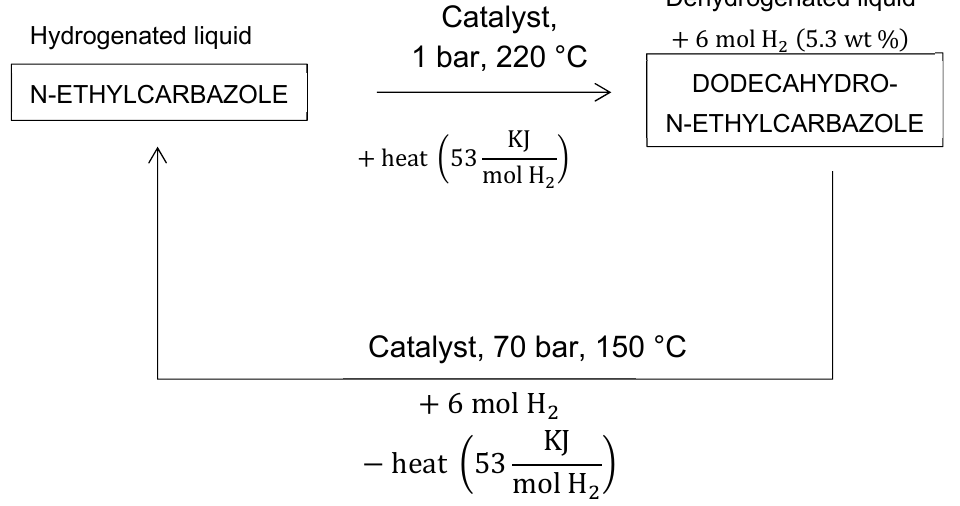
Figure 5. N-ethylcarbazole hydrogen uptake and release. [164].